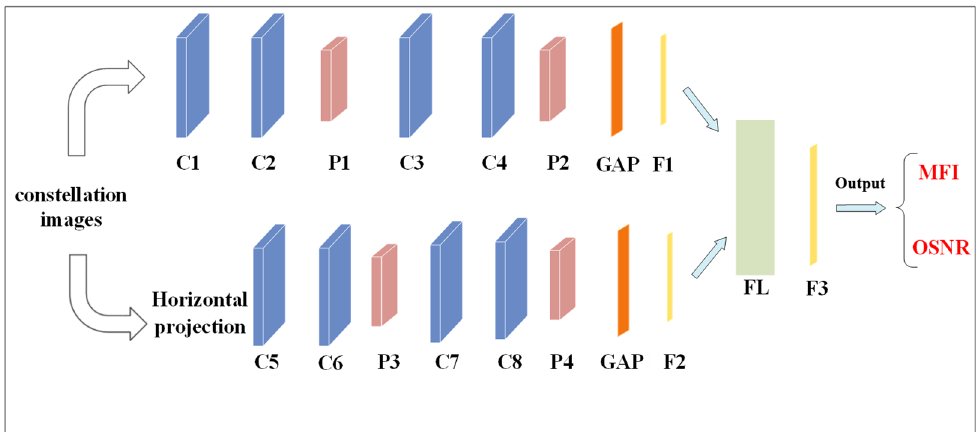
Figure 2. Schematic diagram of the structure for the MFF-Net model.